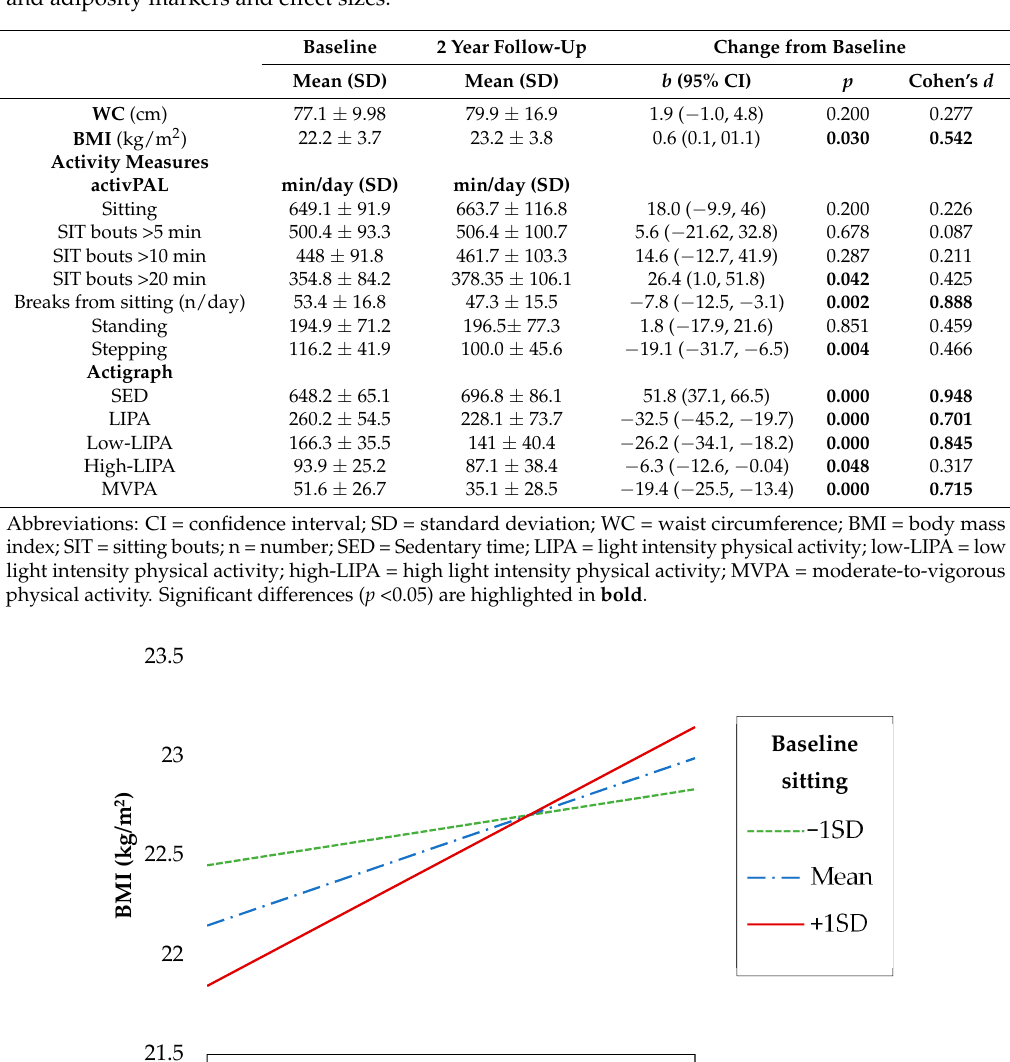
Table 1. Participants’ characteristics and 2-year changes in sedentary/sitting and activity measures and adiposity markers and effect sizes.